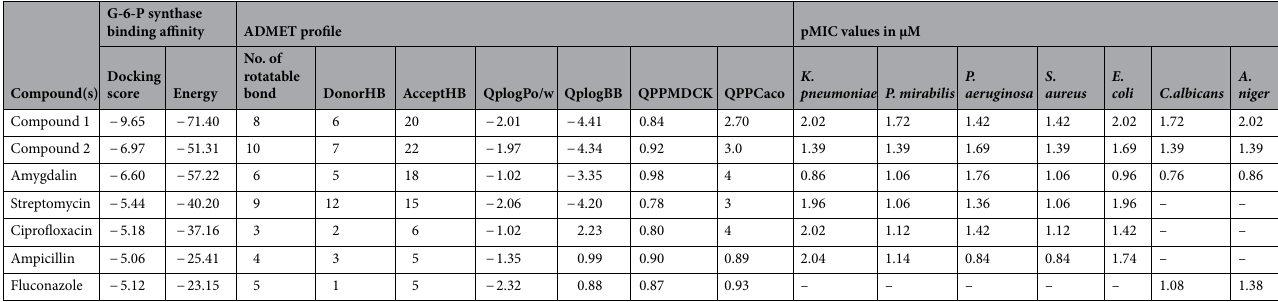
Table 1. Docking parameters, ADMET profile and pMIC value of selected amygdalin